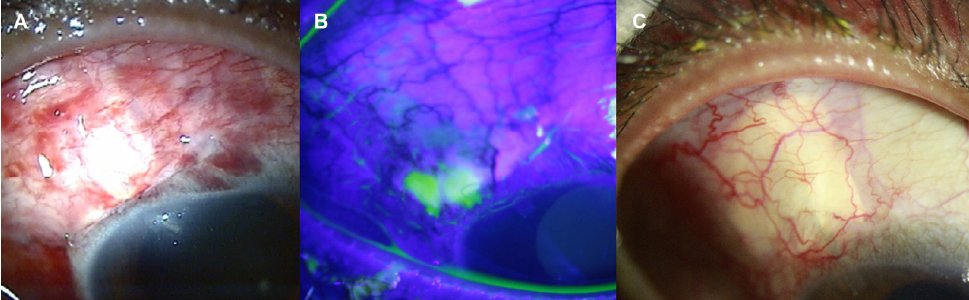
four quadrants of the right eye and the normal range of RNFL in the left eye. ( C ) Humphrey 30-2 visual fi eld revealed of visual fi eld narrowing in the right eye compared to the left eye.